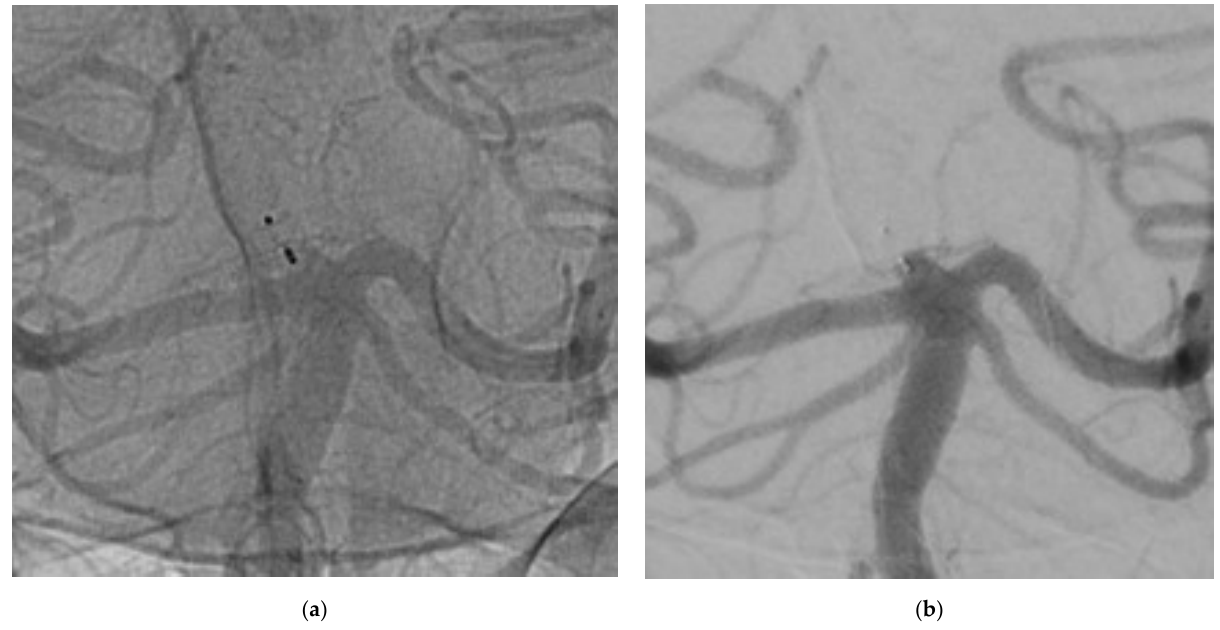
Figure 1. The images show a wide neck aneurysm of the apex of the basilar artery treated using WEB 3 × 2 mm. ( a ) not-substracted DSA at 3-years, ( b ) substracted DSA at 3-years. An aneurysm adeguate occlusion was detected and confirmed by 3D protocol.